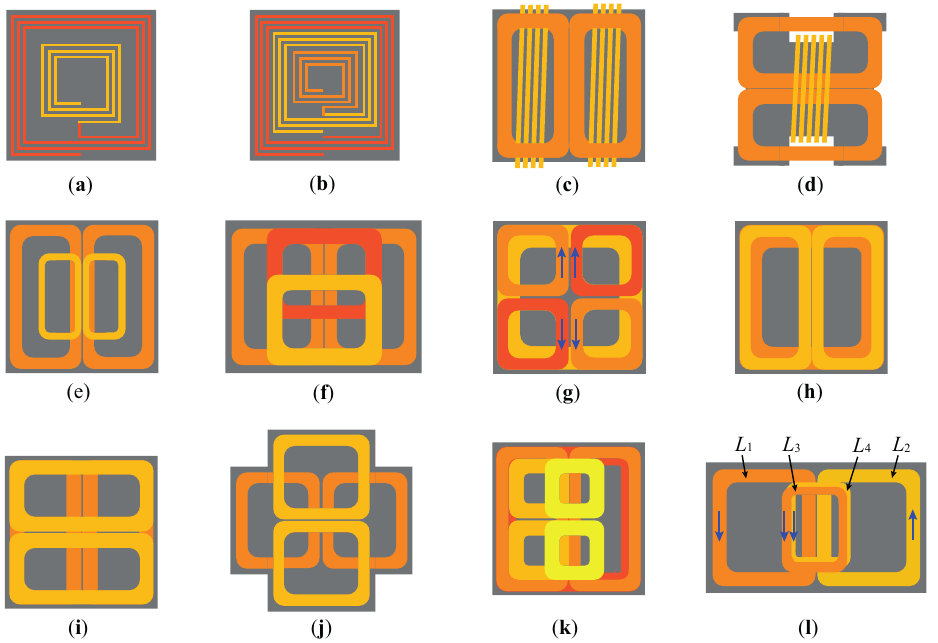
Figure 5. Integrated magnetic coupler topologies. ( a ) Reversely series coils [91,92]. ( b ) New reversely series coils [102]. ( c ) SDDP coils [106,107]. ( d ) Orthogonal decoupled transformer [109]. ( e ) Over- lapped DD coils [110]. ( f ) DD two-quadrature (DD2Q) coils [87]. ( g ) Quadruple-D Quadrature Pads (QDQPs) [78]. ( h ) Overlapped rectangular and DD coils [114]. ( i ) Orthogonal overlapped DD coils [79]. ( j ) Cross-shaped hybrid DD coils [81]. ( k ) Overlapped rectangular and multi-DD coils [83]. ( l ) Decoupled Multi-Unipolar Coils